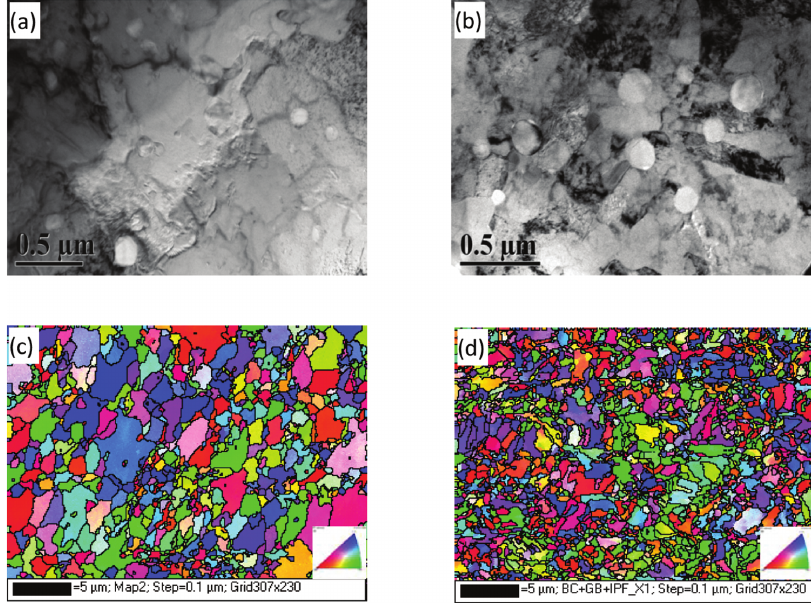
Figure 1: (a), (b) TEM images of HIPed and heat-treated ODS steels, (c), (d). EBSD images of HIPed and heat-treated ODS